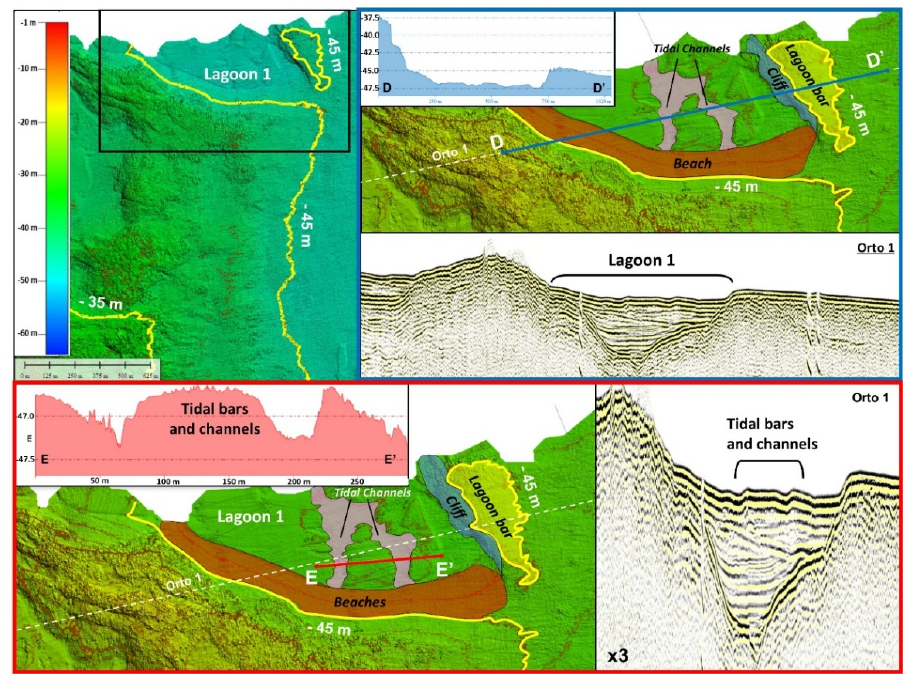
Figure 8. Visualization of Lagoon 1 (L1) with Multibeam data (profile D–D ′ ) and its seismic-strati- graphic setting (Orto 1). The profile E–E ′ represents a detail of the central portion with the develop- ment of a system of tidal bars-channels.